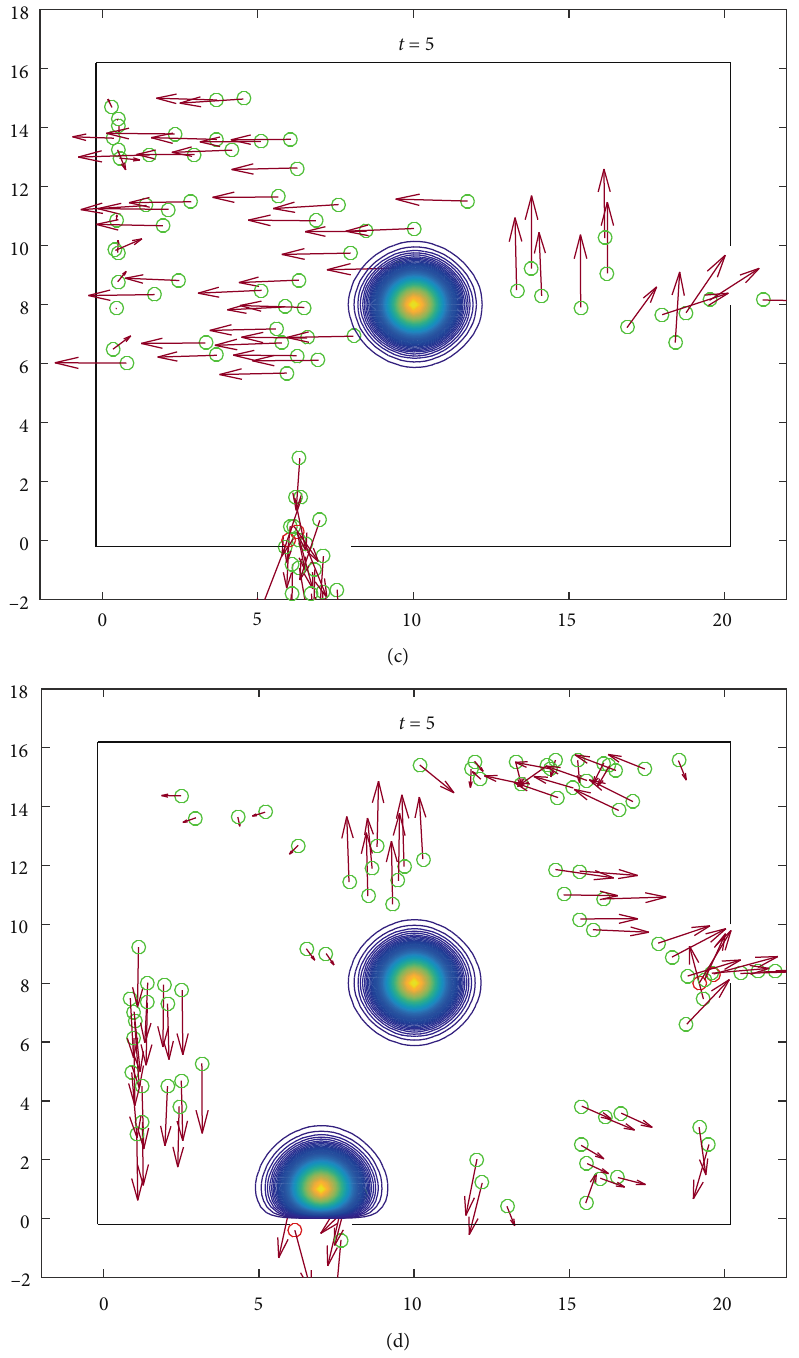
Figure 6: Movements of 100 pedestrians with 3% guiders during smoke spreading where there are one and two sources of smoke. For a source of smoke, it is located in the middle of the room. Two sources of smoke are placed in the middle of the room and in front of exit 1. The simulation domain is a room with two exits as Figure 3(b). The entire time period of a simulation is 50s. (a) 1 smoke source, t